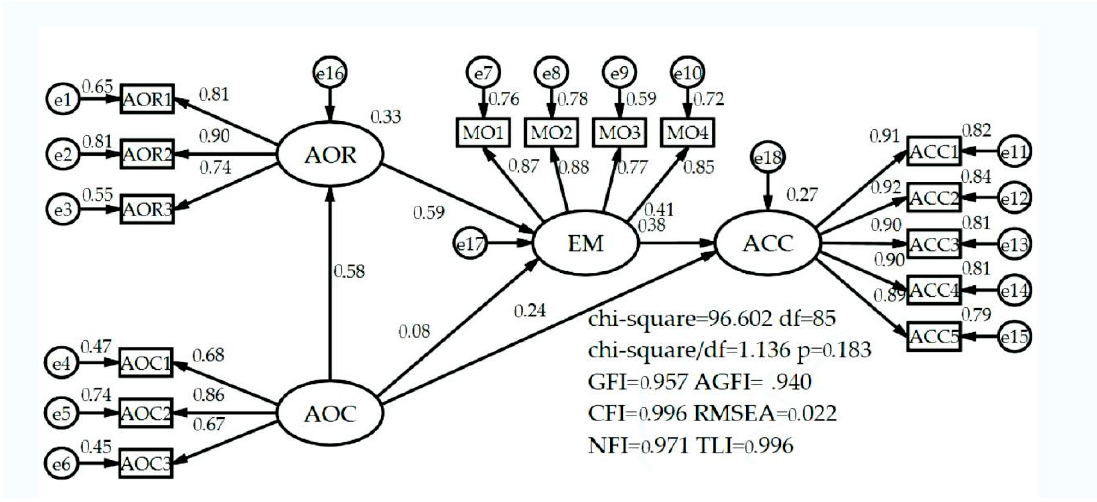
Figure 4. Recycled water NAM.